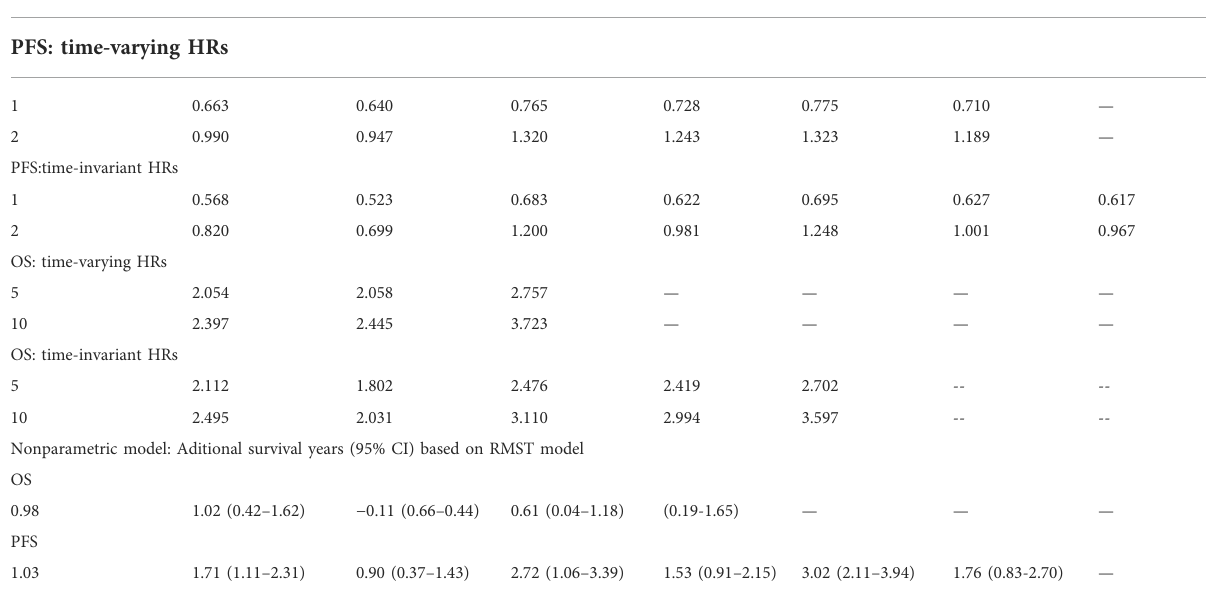
TABLE 2 Overall survival and progression-free survival estimates for different regimens added to